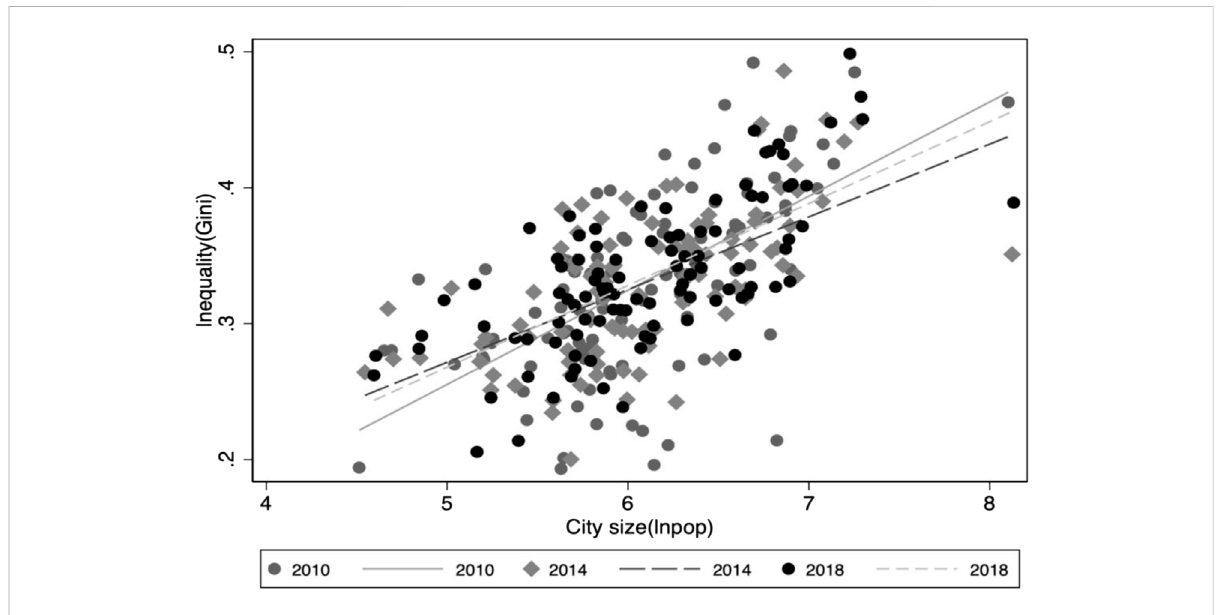
FIGURE 1 Gini coef fi cient and city size (2010, 2014, and 2018) 1